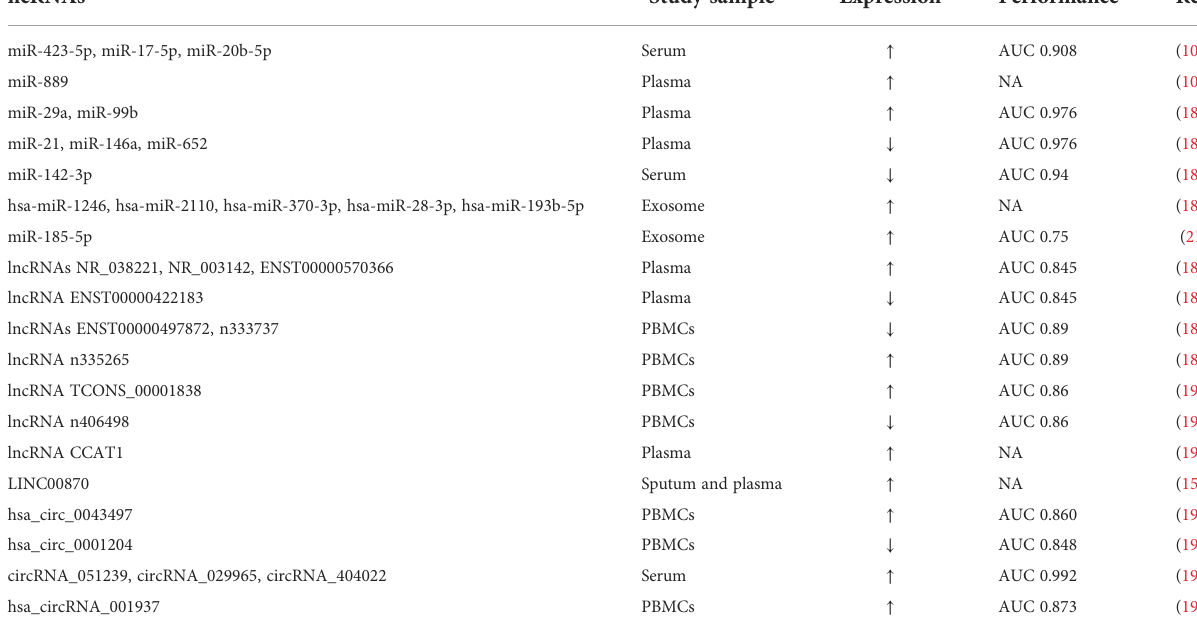
TABLE 4 Noncoding RNAs as biomarkers for tuberculosis diagnosis.